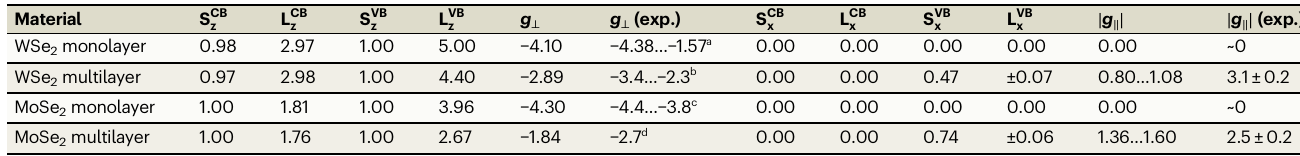
Table 1 | Computed values of out-of-plane and in-plane spin-, S, and orbital, L, angular momenta for the conduction-band (CB) and valence-band (VB) states, which are relevant for the A excitons of the investigated materials